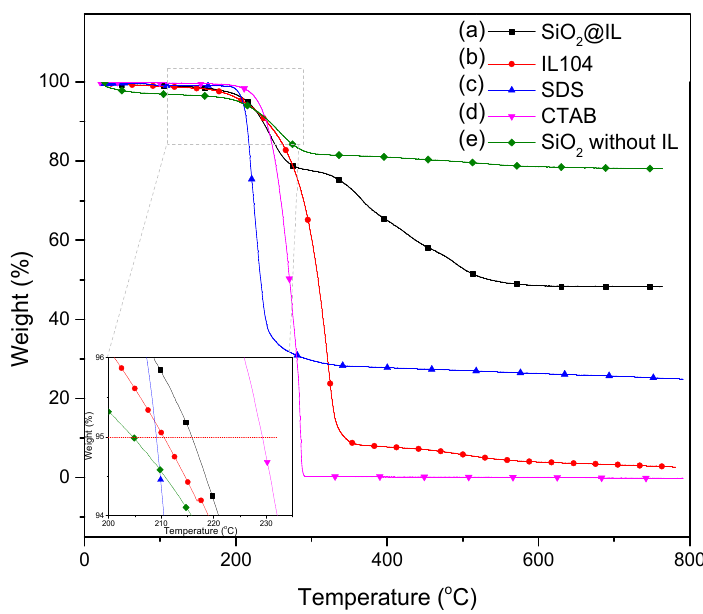
Figure 6. TGA curves of ( a ) SiO 2 @IL, ( b ) IL 104, ( c ) SDS, ( d ) CTAB, and ( e ) SiO 2 without IL (heating ramp: 10 K min − 1 ).